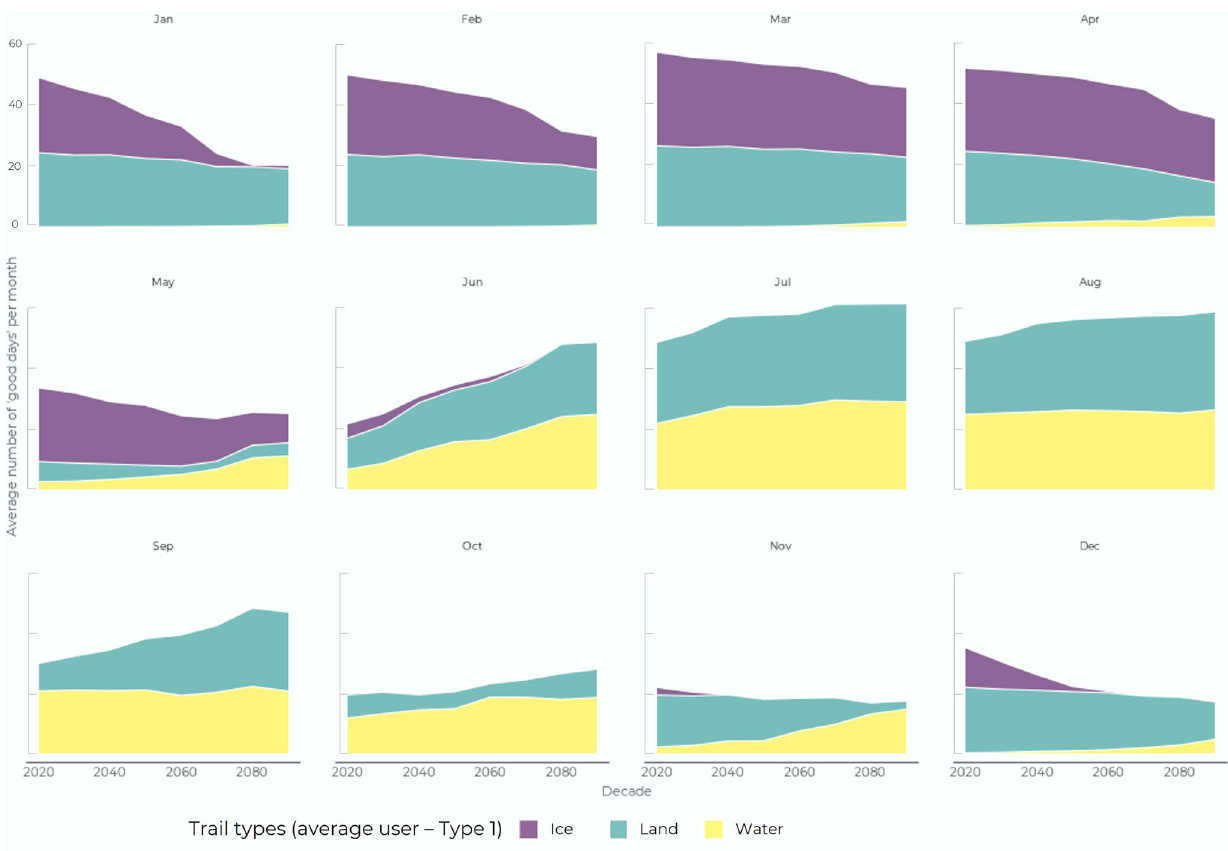
Fig. 3 Monthly number of ‘ good days ’ when a trail is usable. This is modeled for Type 1 (average) trail users for all trail types for SSP585 and averaged across all communities (decadal averages; e.g. “ 2020 ” is year 2020 to